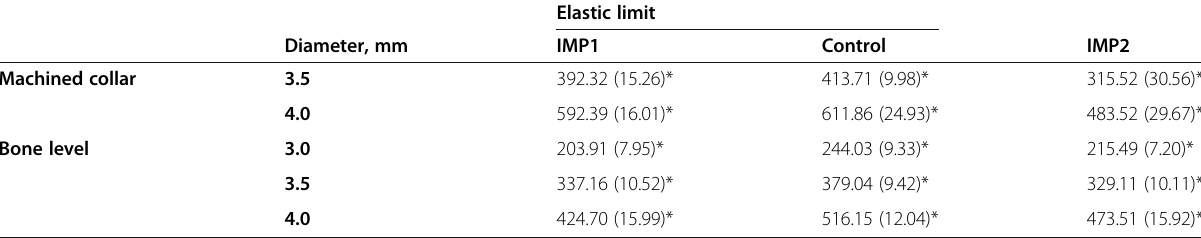
Table 1 Mean elastic limits for different implant diameters and designs in all study